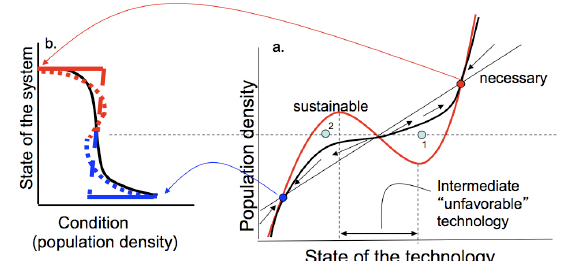
Fig. 8 . Population dynamics model of agricultural regime